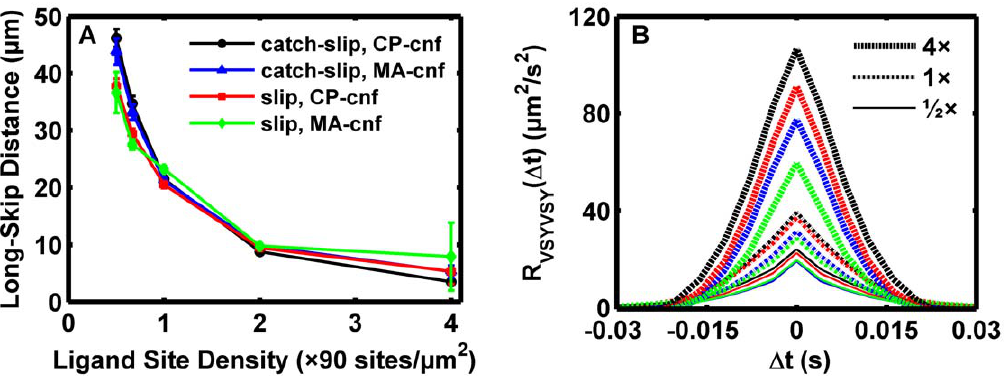
Figure 9. Long-skip distances and wobble differentially reflect molecular activity. Reactive spheres were simulated with S=50 s 2 1 , R=4.9 m m, 1 6 n L u =90 sites/ m m 2 , and n R u =95 sites/ m m 2 . Association kinetics were governed by (1) or (2). Catch-slip parameters regressed from Marshall et al. [5,32] were used in the catch-slip model, (4), or the just the high-impedance pathway parameters were entered into the slip model, (3). (A) The long-skip distance calculated from the two-parameter Poisson regression at a variety of ligand concentrations. Black circles: the catch-slip model was assumed with contact patch confinement. Blue triangles: the catch-slip model was assumed with molecular area confinement. Red squares: the slip model was assumed with contact patch confinement. Green diamonds: the slip model was assumed with molecular area confinement. Error bars show the 95% confidence interval estimate from the nonlinear regression. Surprisingly, the dissociation model had a moderate effect on the skip distance at low site densities but the confinement model had little effect. (B) The sample-normalized autocorrelation of the velocity component perpendicular to the flow direction (wobble velocity autocorrelation) was calculated and averaged together for the three simulated beads at each condition. The colors indicate the same reaction assumptions as in the previous graph. Heavy dashed lines: results from 4 6 90 sites/ m m 2 ligand density. Intermediate dot-dashed lines: results from 1 6 90 sites/ m m 2 ligand density. Light solid lines: results from K 6 90 sites/ m m 2 ligand density. Colors represent the same cases as in (A). The confinement model had the largest effect on the wobble autocorrelation.